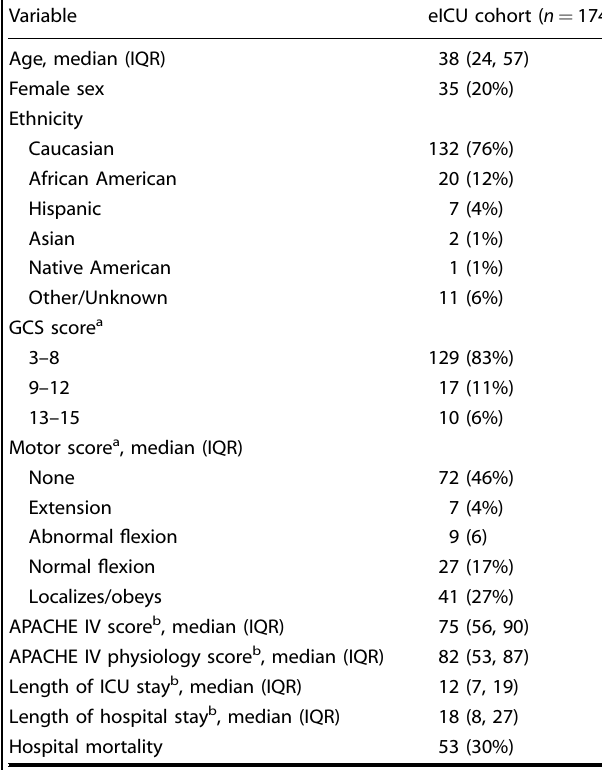
Table 1. Patient characteristics in the training cohort and in the Stockholm cohort.